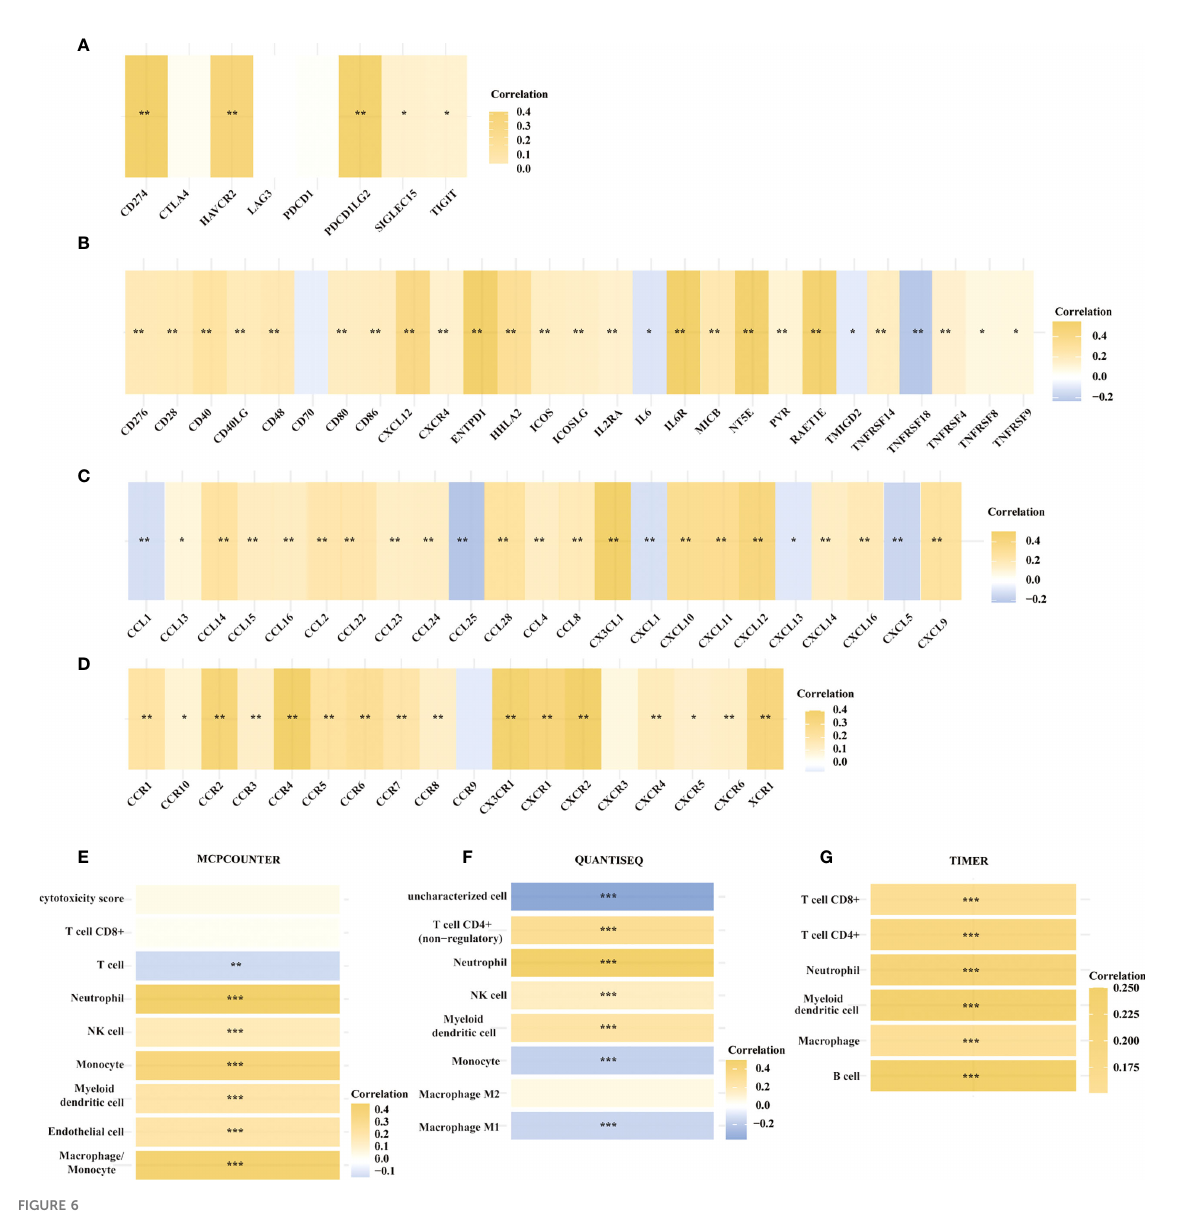
FIGURE 6 The expression of METTL24 was potentially correlated with various immune genes and the in fi ltration levels of multiple immune cells in KIRC. The expression correlation between METTL24 and (A) typical immune checkpoints, (B) cytokines, (C) chemokines, and (D) chemokine receptors; The correlation between METTL24 expression and the in fi ltration degrees of distinct immune cells as analyzed using (E) MCPCOUNTER, (F) QUANTISEQ, and (G) TIMER algorithms. ***p < 0.001, **p < 0.01 and *p <